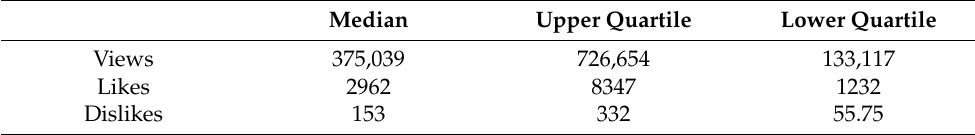
Table 1. 25th, 50th and 75th percentile of views, likes and dislikes of all videos analyzed in this study.